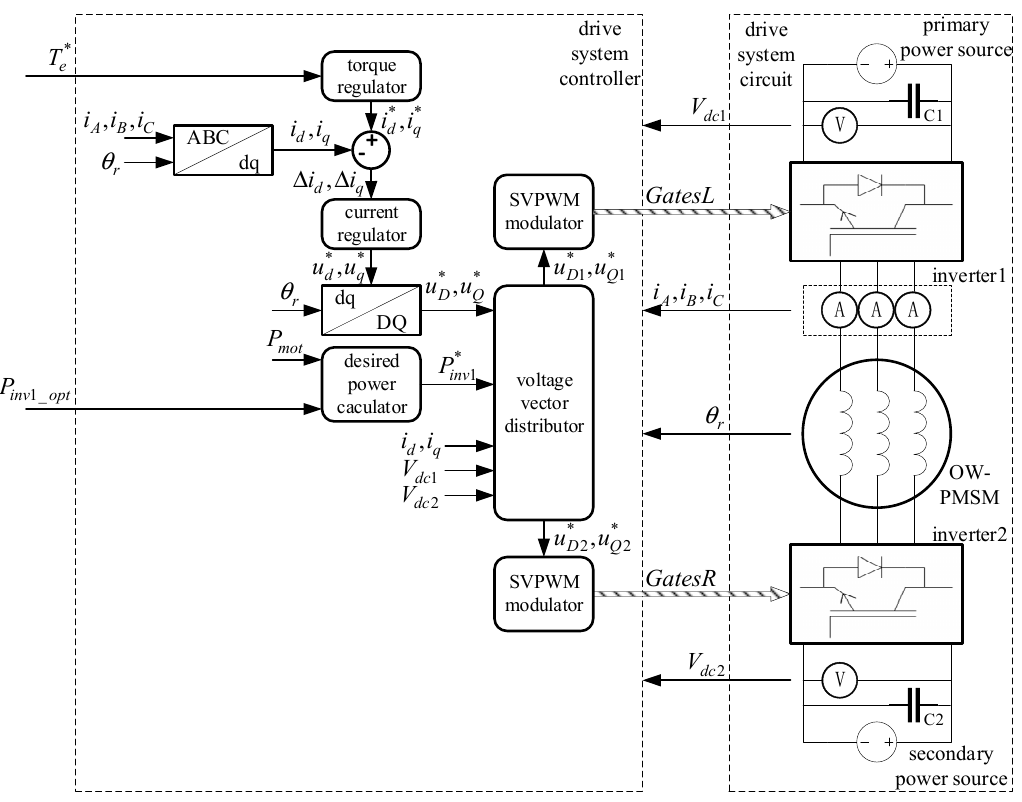
Figure 10. Overall configuration of the proposed system.